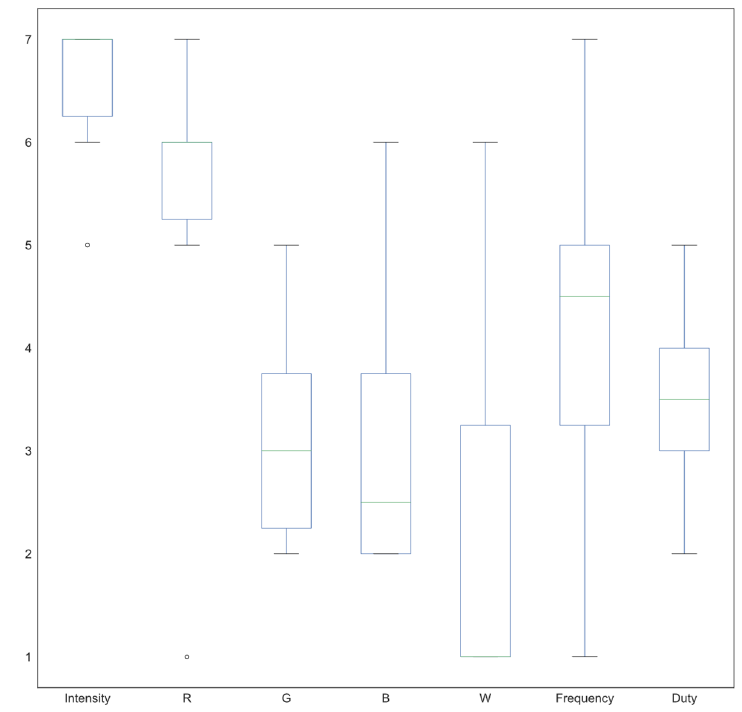
Figure 10. Order of elimination for features in nonlinear models . Table 14. Values obtained with the Kruskal–Wallis test.